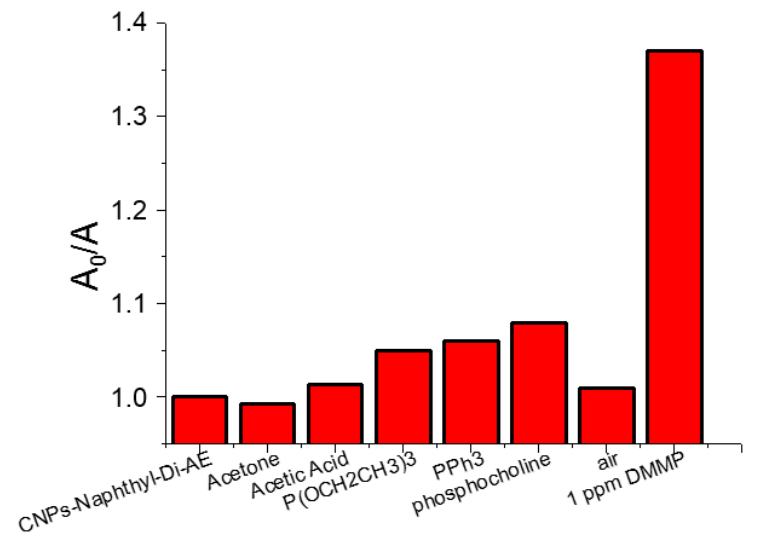
Figure 5. Normalized UV-Vis responses of CNPs-Naphthyl-Di-AE (0.05 mg/mL in toluene) to various competitive guests: 50 ppm of acetone, acetic acid, triethylphosphite (P(OCH 2 CH 3 ) 3 ), triphenylphosphine (PPh 3 ) and phosphocholine; air (bubbled for 30 min); and DMMP (1 ppm). Bars represent the initial over the final absorbance values at 430 nm.